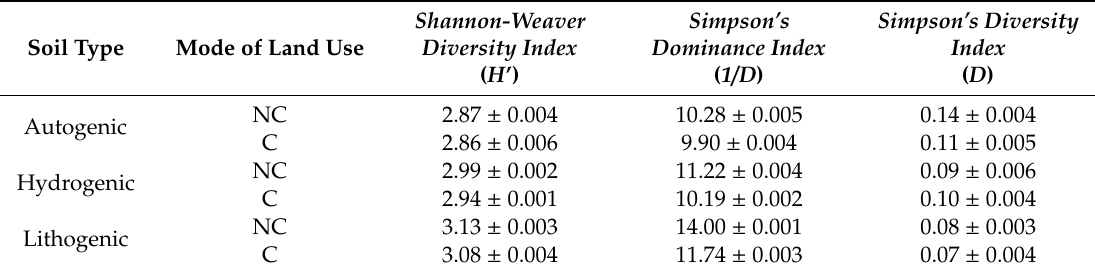
Table 3. Analyses of the diversity of Actinobacterial 16S rRNA amplicons in Lublin Region soils ( ± SD